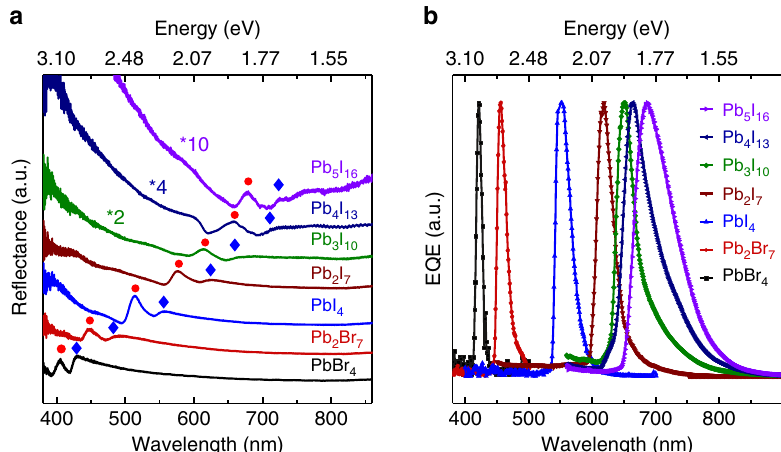
Fig. 3 Narrowband photodetection in the entire visible range. a Re fl ection spectra of the perovskite single-crystal plates. Red dots indicate the exciton peak, whereas blue rhombus mark the self-trapped states below the bandgap. b Normalized EQE spectra of the vertical devices (Con fi g. 1) based on 2D perovskite of different halide compositions and layer number n . Measurements were carried out under a bias of